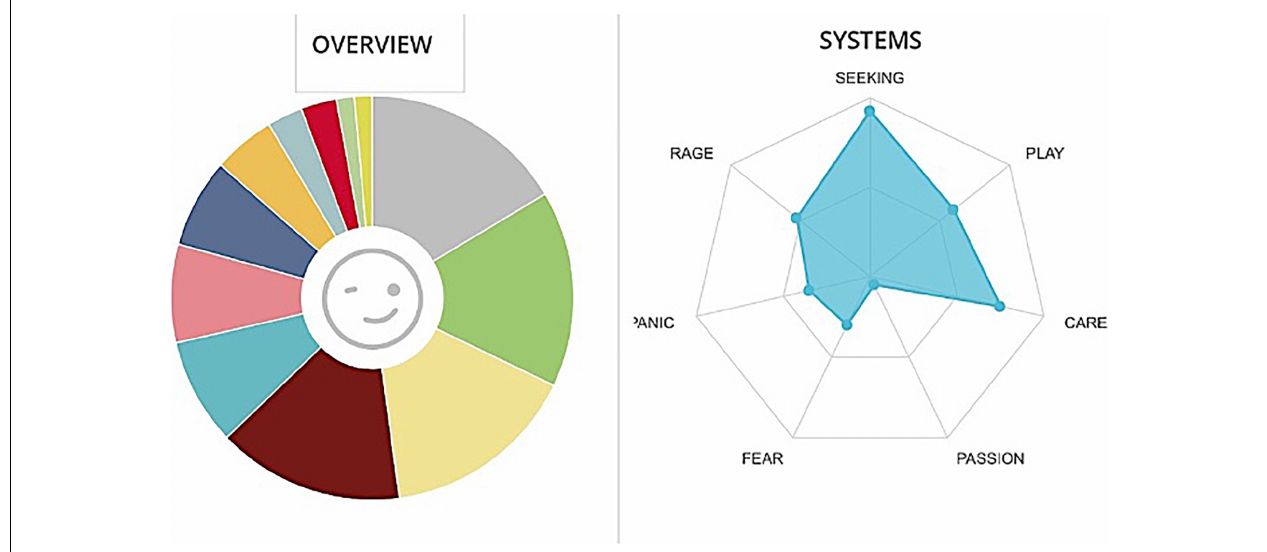
FIGURE 7 | Graphs GB. The cumulative percentages of choice of emotions made by a team are represented in the pie chart (Different colors match to the different emotions as they are displayed in Figure 1 ) while the web graph shows the correspondence between chosen emotions and emotional systems.